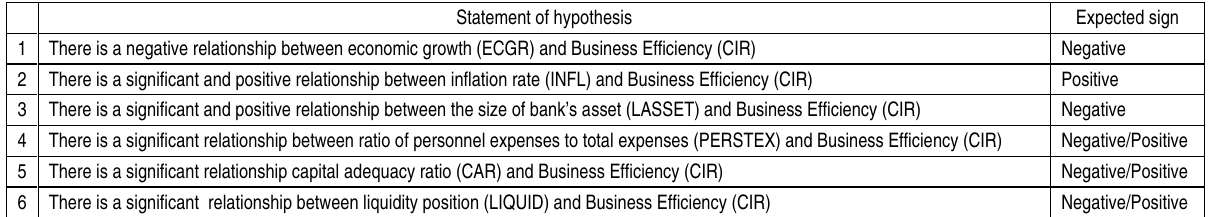
Table 2. Hypotheses relationship between business efficiency and